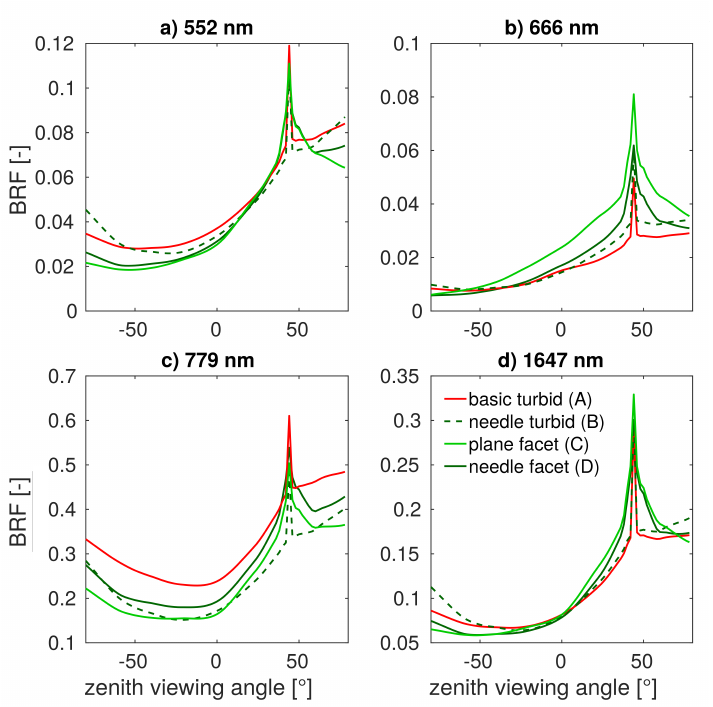
Figure 8. DART-simulated forest canopy reflectance in the solar principal plane for the four simulated scenarios ( A – D ) in four spectral bands ( a ) green—552 nm, ( b ) red—666 nm, ( c ) NIR—800 nm, and ( d ) SWIR—1647